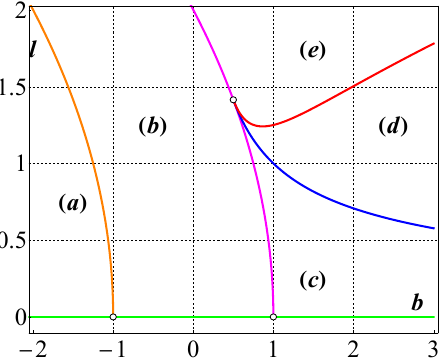
Figure 1. The atlas of the bifurcation